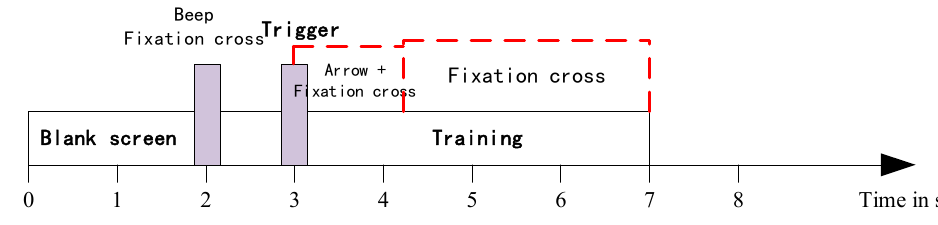
Figure 11. Example of an experimental cycle.